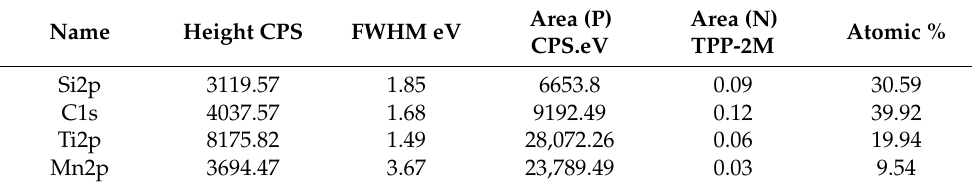
Table 1. XPS analysis of the Mn-Ti Modified zeolite.